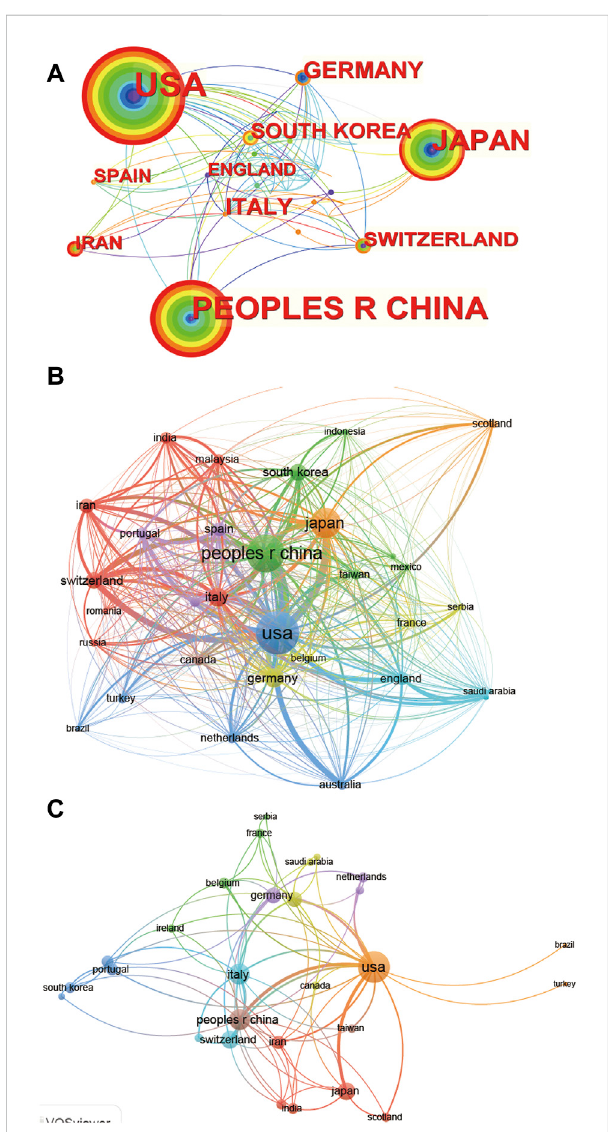
FIGURE 4 Mapping of countries/regions associated with stem cells for meniscal regeneration. Country/regional collaboration analysis derivedbasedonCiteSpace (A) andVosviewer (B) . (C) Theauthorship- country collaboration analysis via Vosviewer. The nodes represent countries/regions, and the lines connect them. The number ofpublicationsgrows proportionallytothesize ofthenodes.Thelines between the nodes represent the cooperation relationship, and the thickness of the connecting lines represents the strength of their cooperation; the closer the cooperation is, thethicker theconnecting lines. The nodes with the outermost orange circles have higher